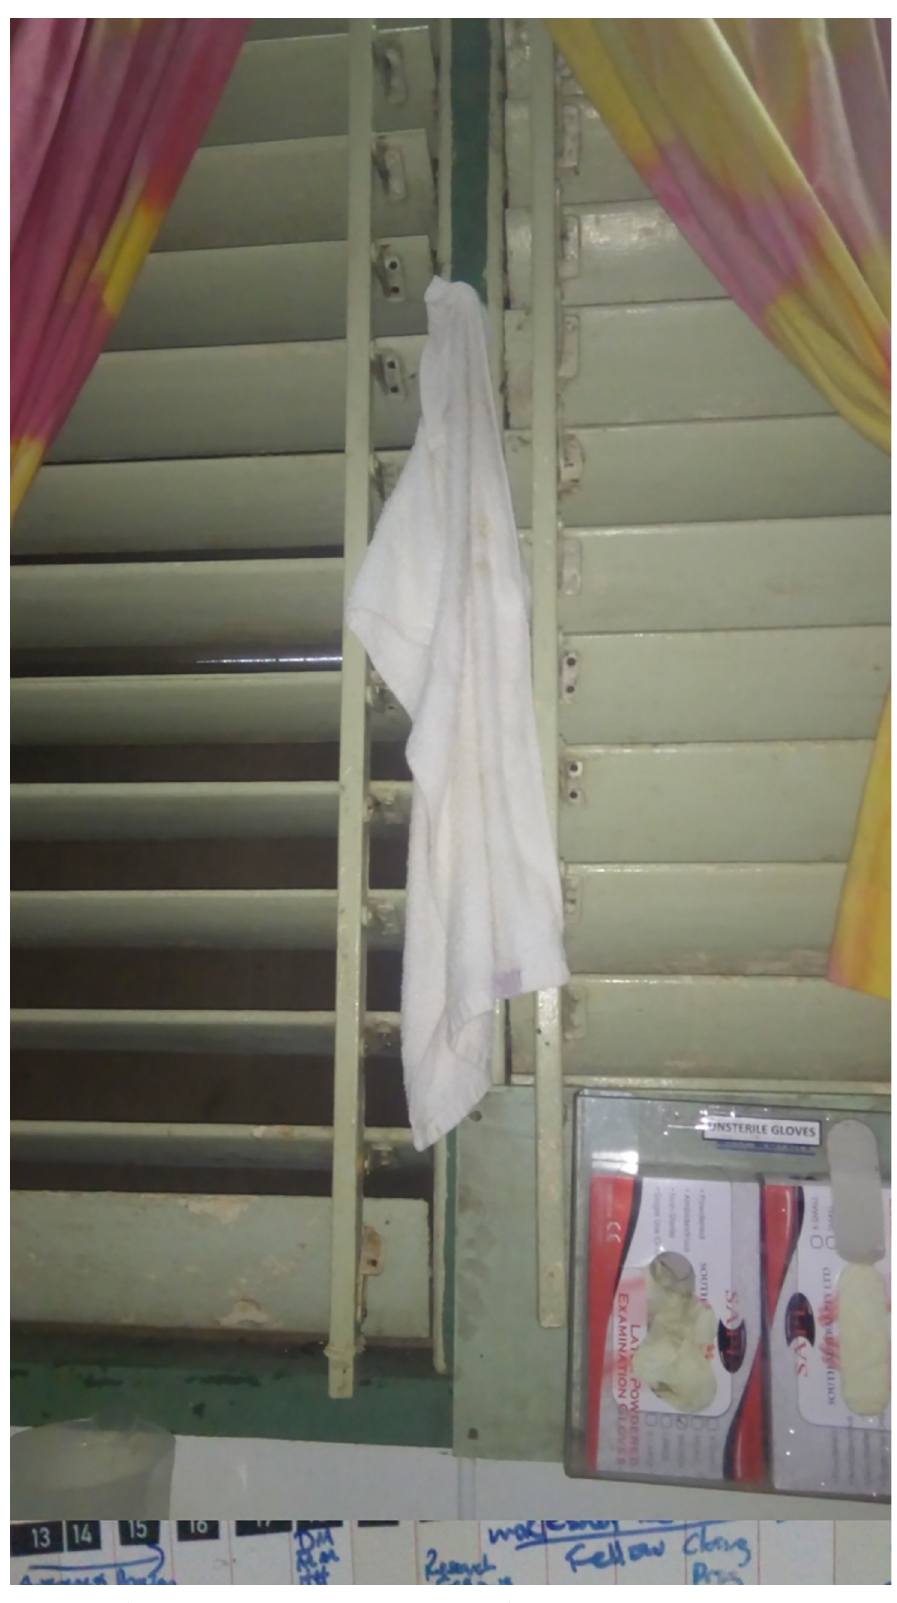
Fig 2. SNP02 (Same hand towel, more hands, more infection).